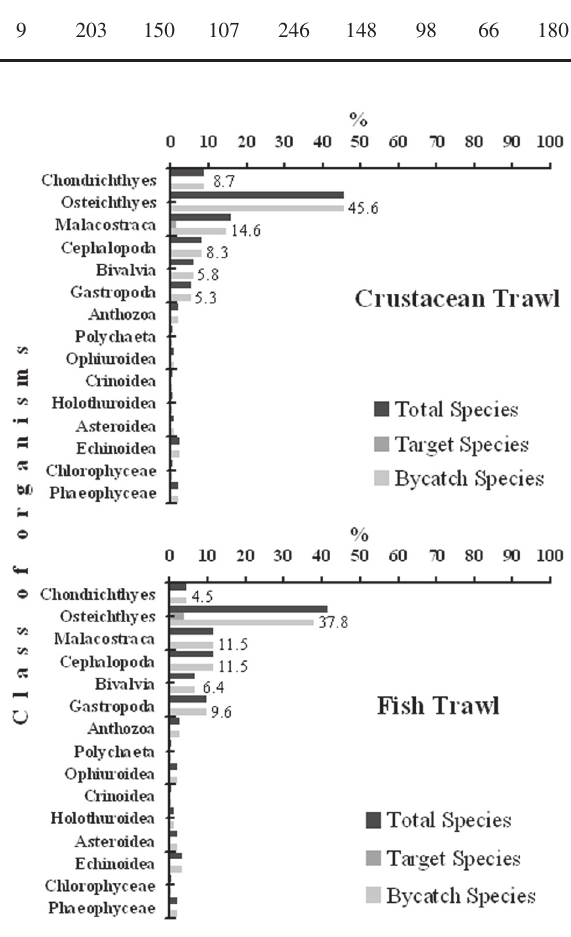
Fig . 5. – Contribution of each class of organisms to the biodiversity of the total, target and bycatch catches in the two types of trawlers. Each bar represents the percentage of the species in that class in relation to the total number of species